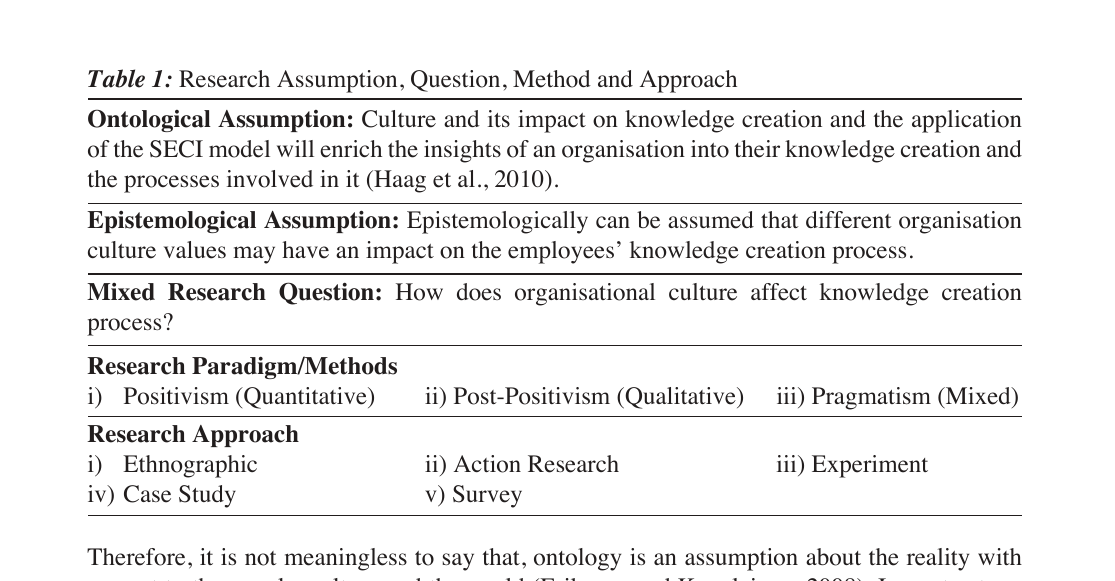
Table 1: Research Assumption, Question, Method and